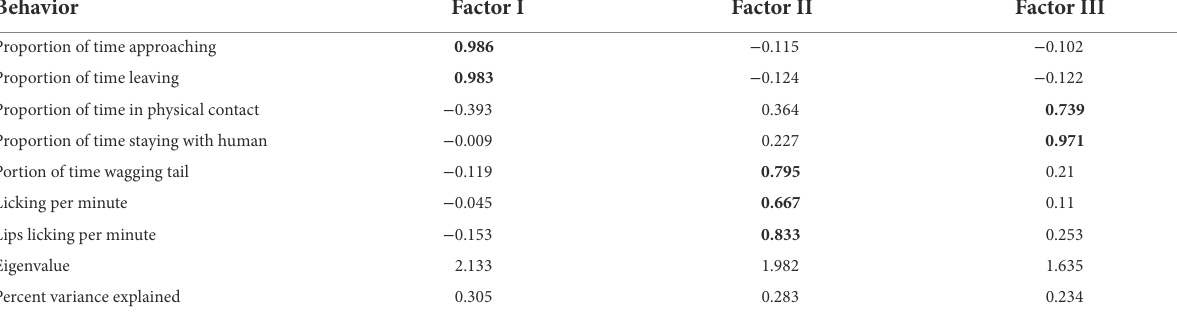
TABLE 5 Social interaction behavioral factor